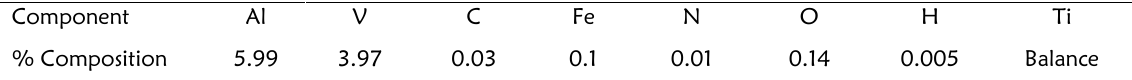
Table 4: Chemical Composition of Ti-6Al-4V